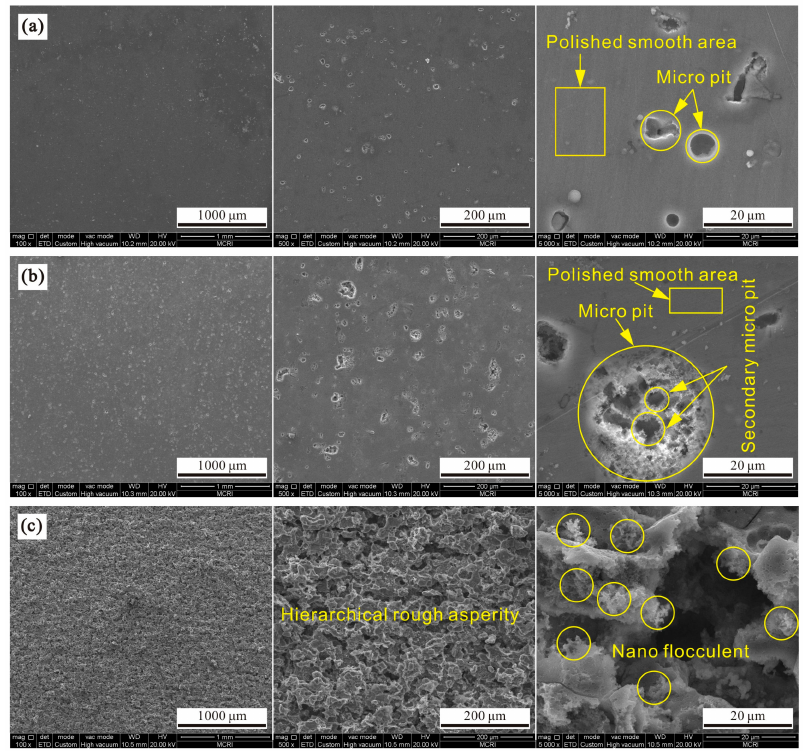
Figure 1. Scanning electron microscopes at various magnifications for 7075 aluminum alloys after etching for ( a ) 1 min, ( b ) 3 min and ( c ) 5 min.